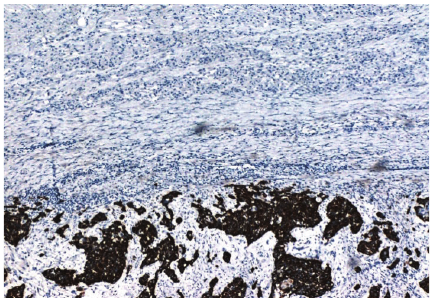
Figure 3: Infiltration of a skeletal muscle from a malignant lesion compatible with a high grade urothelial carcinoma positive to the CK7